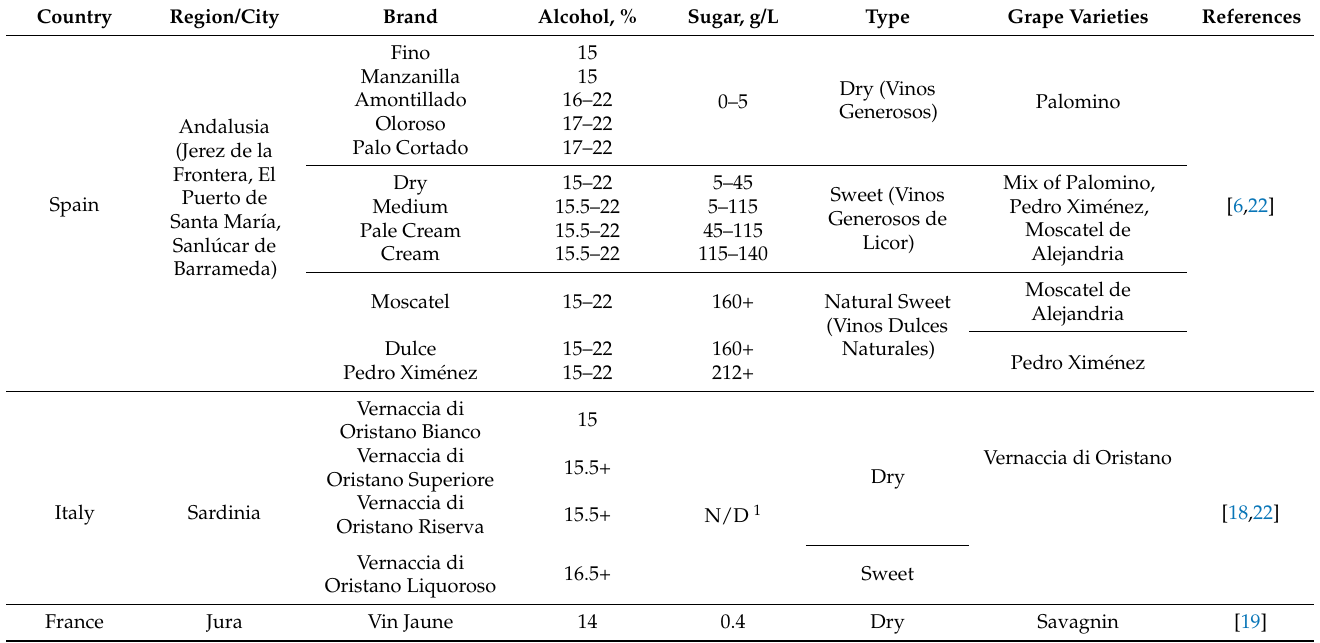
Table 1. Major sherry and sherry-like wine production worldwide and their analytical